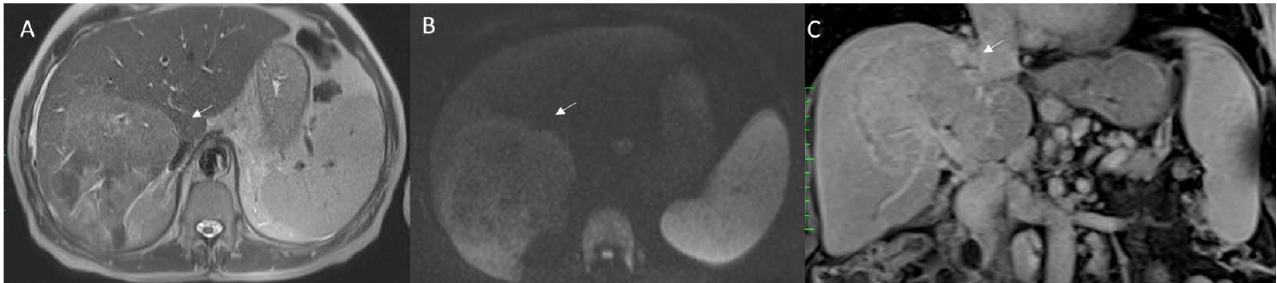
Figure 5. Pancreatic cancer patient. MRI staging assessment (arterial ( A ) and portal ( B ) phase of contrast study). The arrows show right hepatic artery origin from the superior mesenteric artery.